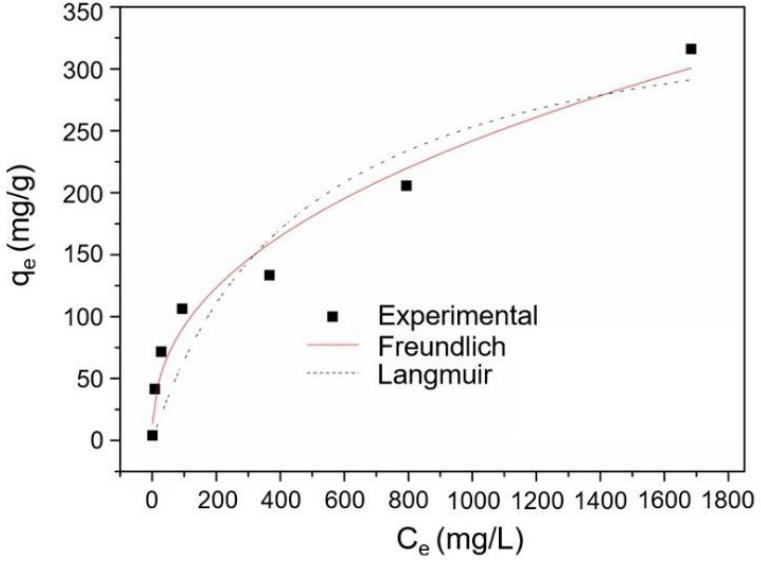
Figure 6. The drug adsorption isotherms for cellulose-PEI. To better understand the interaction between NaSA and cellulose-PEI, the adsorp- tion isotherms of cellulose-PEI were fitted by Langmuir model [41] (Equation (4)) and